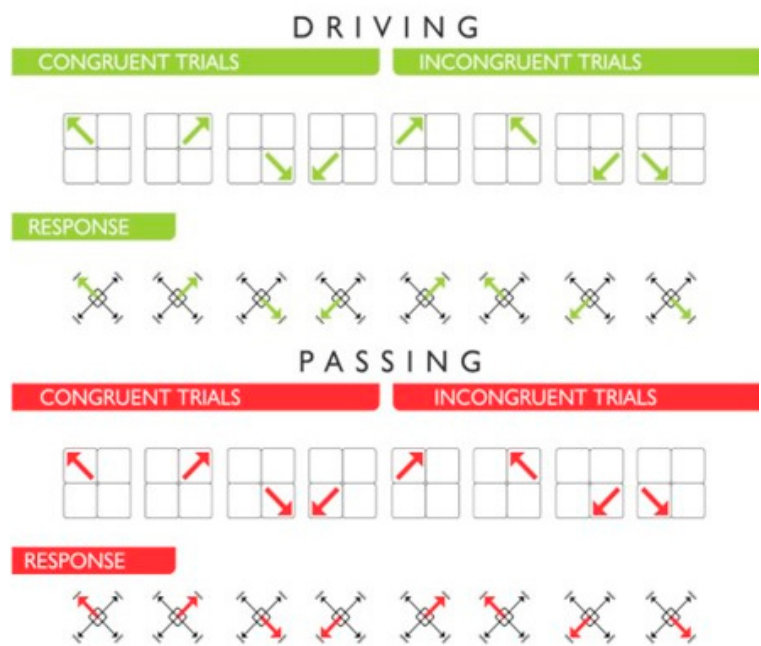
Figure 2. Scheme of stimuli and responses. The stimuli appeared in one of the four quadrants in a congruent or incongruous manner and with red or green arrows. The response appeared in one of the four directions.